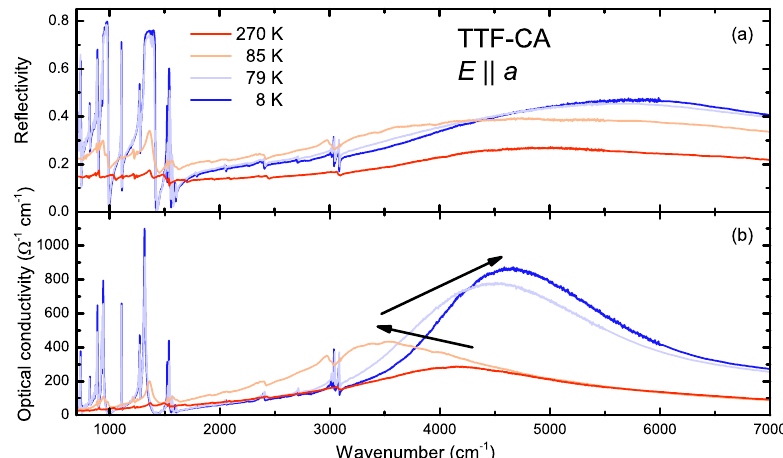
Figure 16. ( a ) Reflectivity and ( b ) optical conductivity of TTF-CA measured in the mid-infrared range for E (cid:107) a from T = 295 K to 8 K. The spectrum is divided into the region from 700 cm − 1 to 3200 cm − 1 where intramolecular modes dominate, and in the higher frequency range, where the features originate from electronic